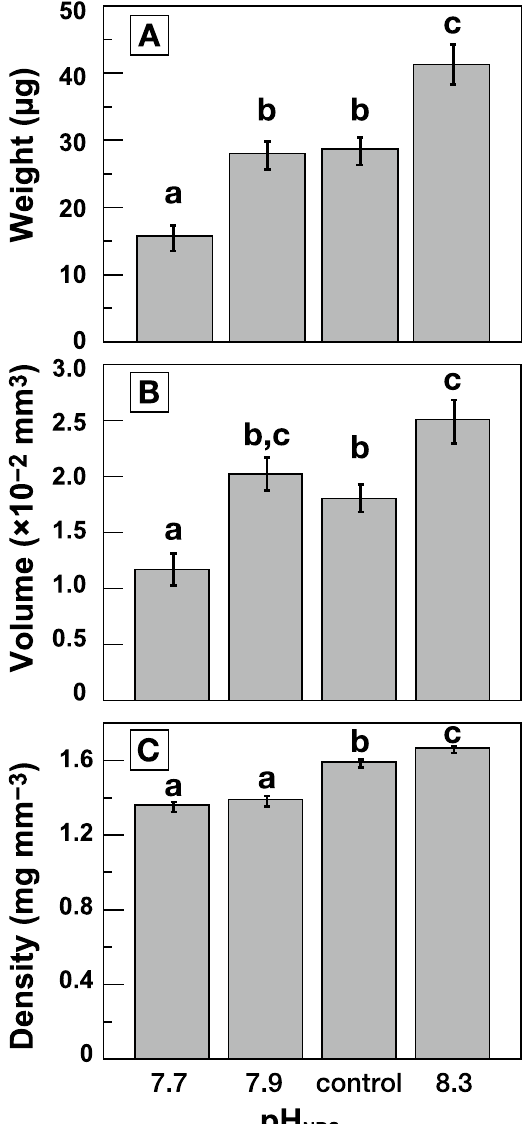
Figure 1. Mean shell ( A ) weight, ( B ) volume, and ( C ) density of Amphisorus kudakajimensis shells cultured under four pH conditions. Error bars indicate the standard errors of the corresponding mean values. Letters above the bars indicate significant differences according to Tukey’s HSD tests (α = 0.05) on shell weight 1/3 , volume 1/3 , and density. Tukey’s HSD tests were performed using JMP Pro statistical software (ver. 15.2.0 for Windows, SAS Institute Japan Ltd., Tokyo,